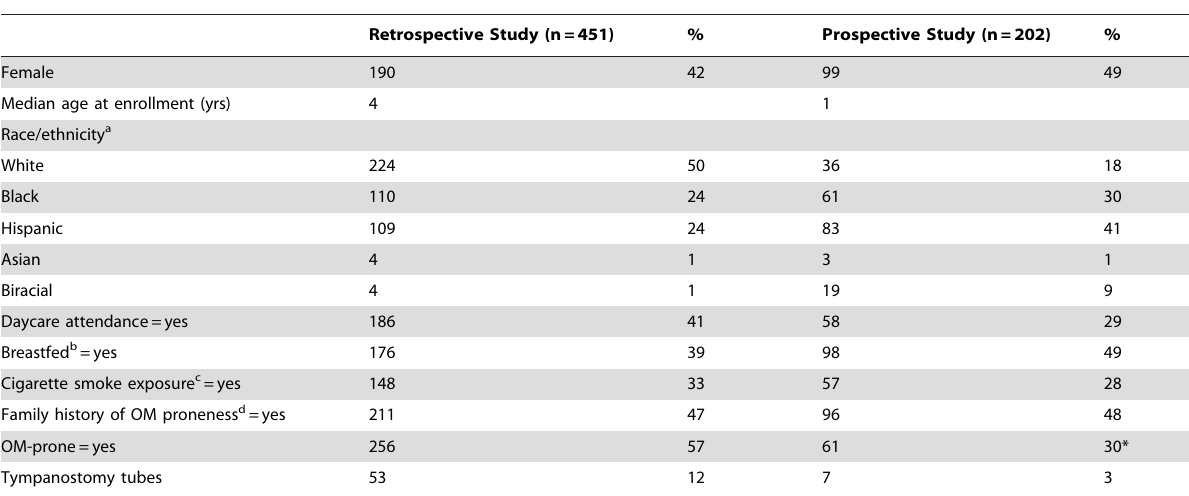
Table 2. Demographic and clinical characteristics of 653 study children.